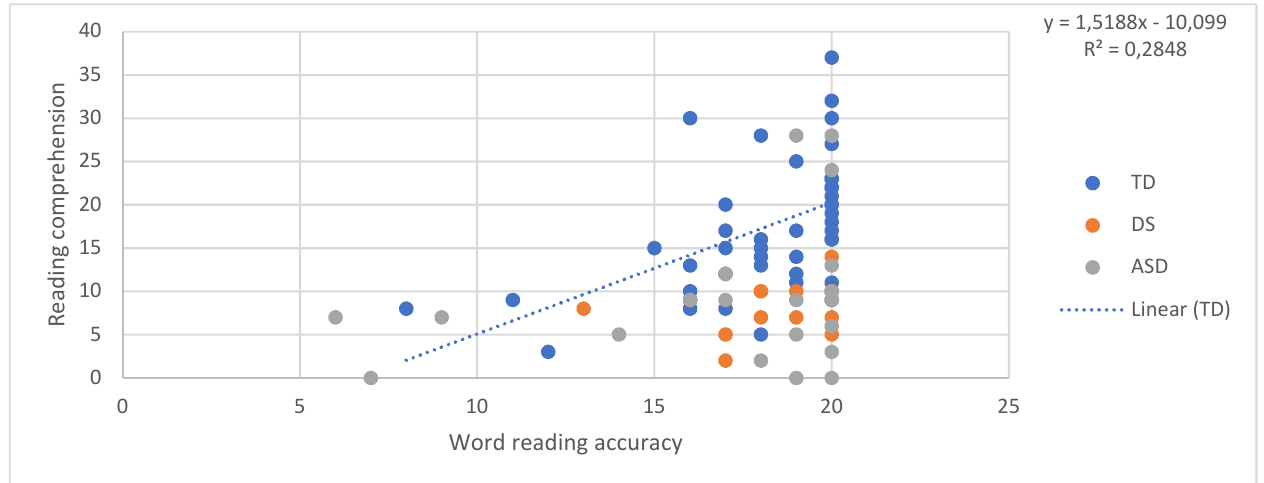
Figure 1. Word reading accuracy predicting reading comprehension.